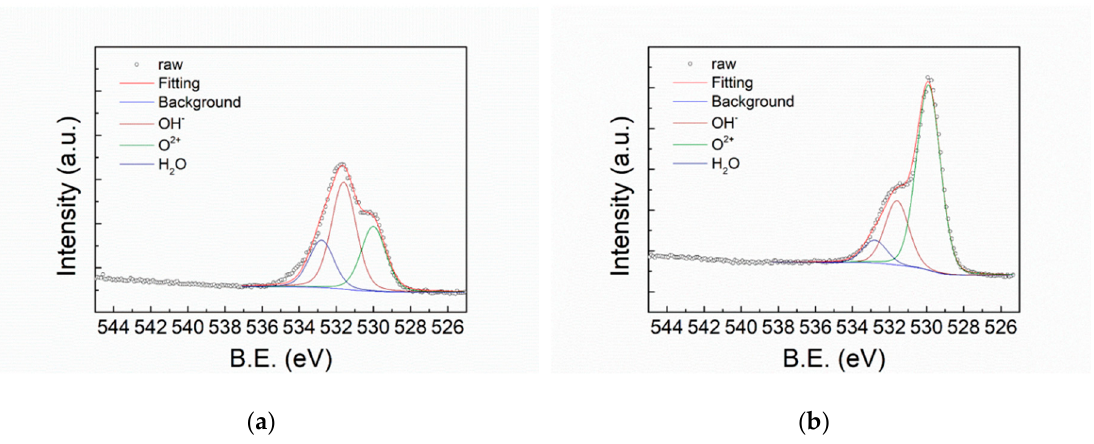
Figure 7. XPS O1s spectra of ( a ) FeCoNiCr and ( b ) APPJ-treated FeCoNiCr MEAs. Table 3. XPS O1s deconvoluted peak areal ratios from XPS spectra shown in Figure 7. O 2+ (at%)